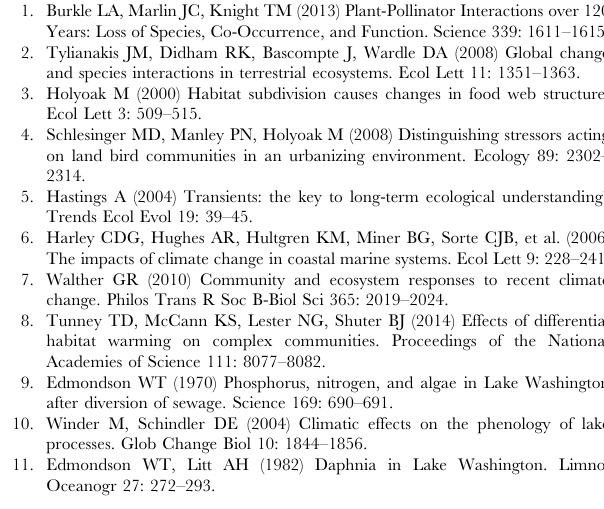
Figure S3 Time series of environmental covariate effects. Interaction coefficients estimated for the Lake Washing- ton time series with a mwMAR model, using an 84-month window. Figures show the effects of covariates in columns on plankton guilds in rows. Figure S4 Quantile-quantile plots of residuals for the Daphnia and Oscillatoria time series. Shown are theoretical versus observed distributions of mwMAR model residuals for all windows where the Shapiro-Wilk test statistic was below the alpha value required to reject the null hypothesis of normally-distributed errors (61/1248 for Daphnia , 175/1248 for Oscillatoria , 0 for DG and 0 for NDC). Table S1 Community and covariate matrix coefficients estimated by a MAR model for the full Lake Washington time